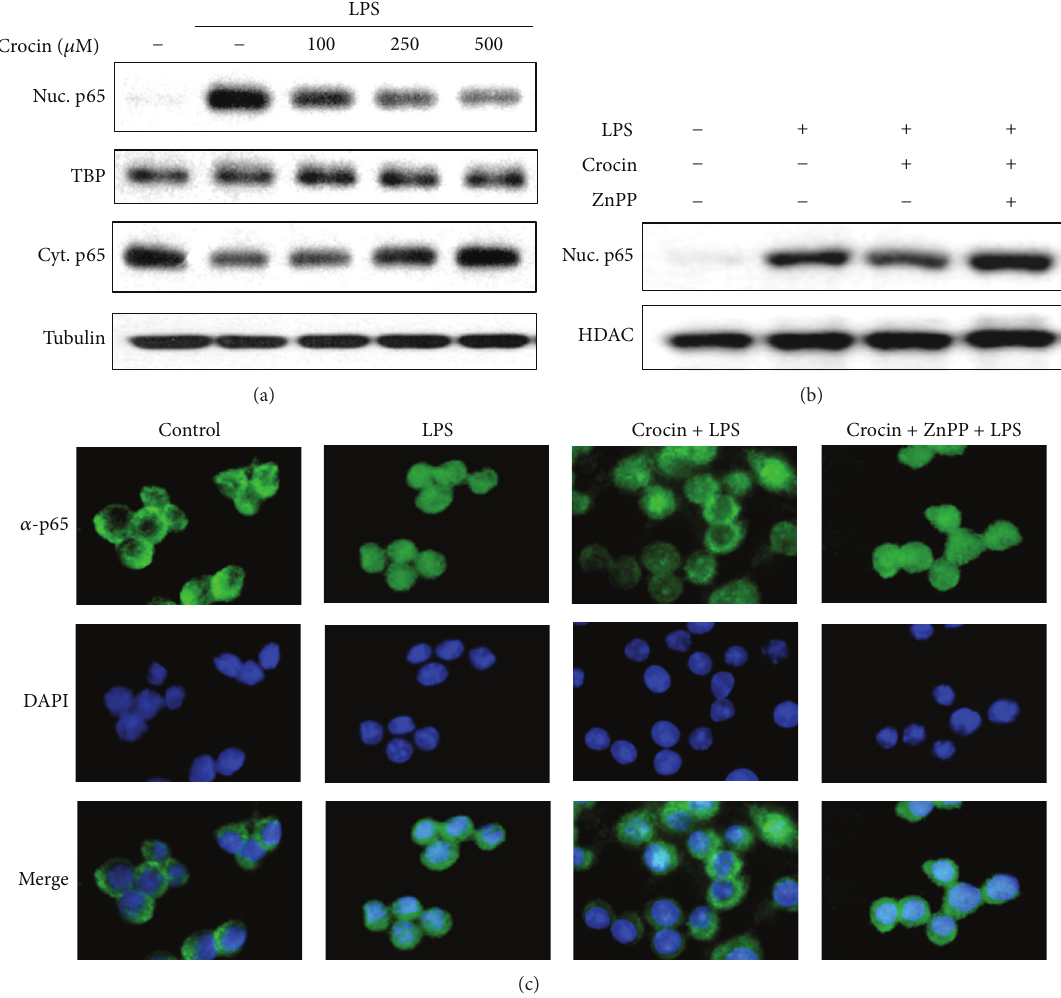
Figure 3: Inhibitory effects of crocin on NF- 𝜅 B translocation in LPS-stimulated macrophages. (a) Cells were incubated with the indicated concentrations of crocin for 3 h and then stimulated with LPS (0.1 𝜇 g/mL) for 30 min, after which nuclear and cytosolic proteins were analyzed by Western blotting. (b) Cells were treated with crocin (500 𝜇 M) in the absence or presence of ZnPP (1 𝜇 M) for 3h and then stimulated with LPS (0.1 𝜇 g/mL) for 30 min, after which nuclear proteins were analyzed by Western blotting. (c) Cells were incubated with crocin in the absence or presence of ZnPP as described above and then stimulated with LPS (0.1 𝜇 g/mL) for 30 min. Fixed cells were subsequently stained with anti-NF- 𝜅 B, FITC-conjugated anti-rabbit IgG antibody, and DAPI, and images were taken using fluorescence